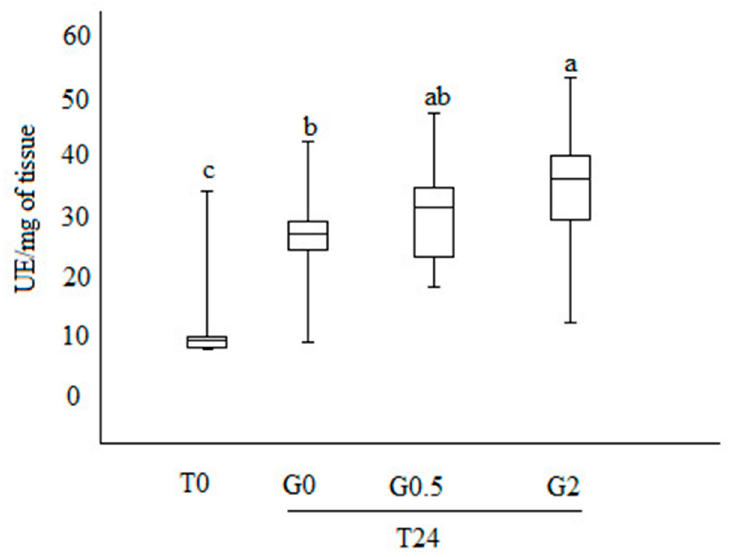
Figure 4. Boxplot representing phenoloxidase activity (expressed in UE / mg of tissue). T0, bees stored at the time of the sample collection; T24, bees after 24 days of rearing; G 0 , G 0.5 , and G 2 , bees fed with 0%, 0.5%, and 2% of 1,3-1,6 β -glucans (w / w) in syrup, respectively. Di ff erent letters show statistically significant di ff erences ( p <